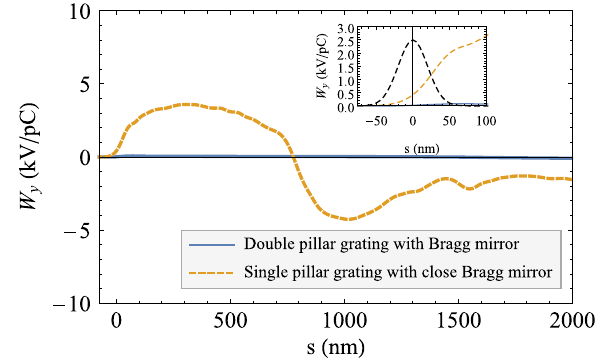
FIG. 6. Transverse wake per grating period of a Gaussian bunch distribution passing a dual pillar structure with a Bragg mirror (blue) and a single-row pillar structure, where the second row is replaced by a Bragg mirror (yellow) on-axis. The inset shows an enlargement of the short-range wake and the reference bunch distribution in black.